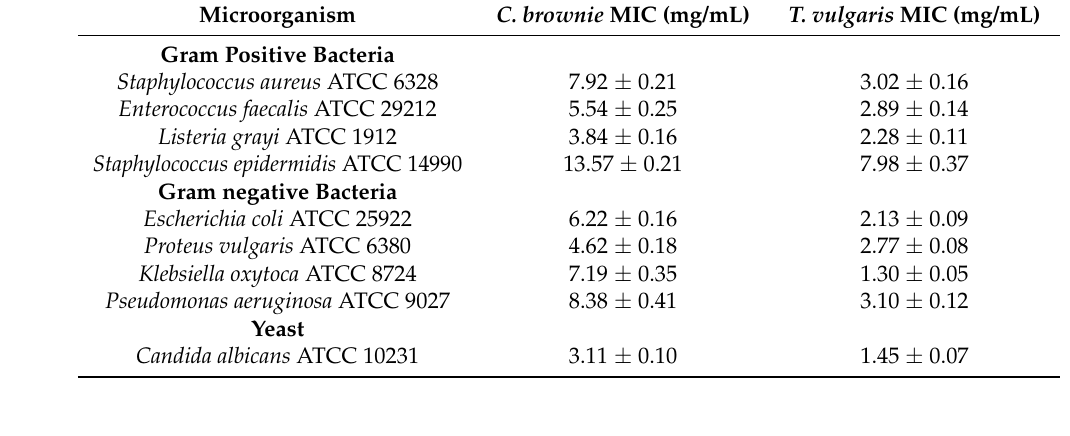
Table 3. MIC values of C. brownei essential oil and T. vulgaris essential oil (natural control) [22] on various microorganisms. Mean ± SD ( n = 4), p < 0.05.